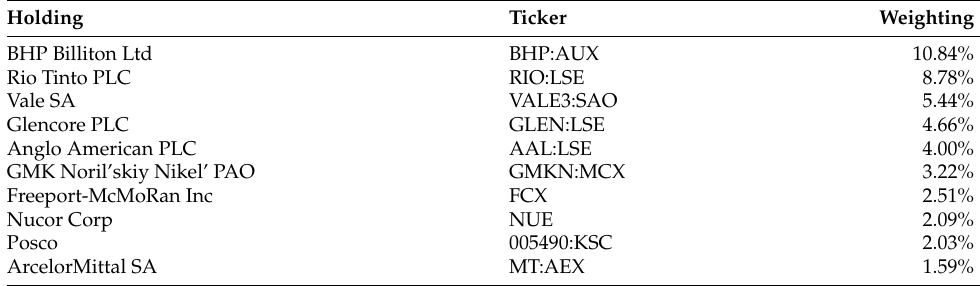
Table A1. iShares MSCI Global Select Metals & Mining Producers (PICK)